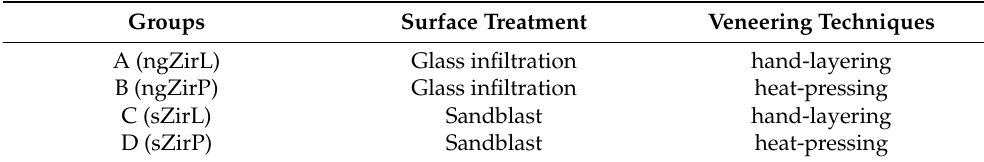
Table 3. The specific grouping